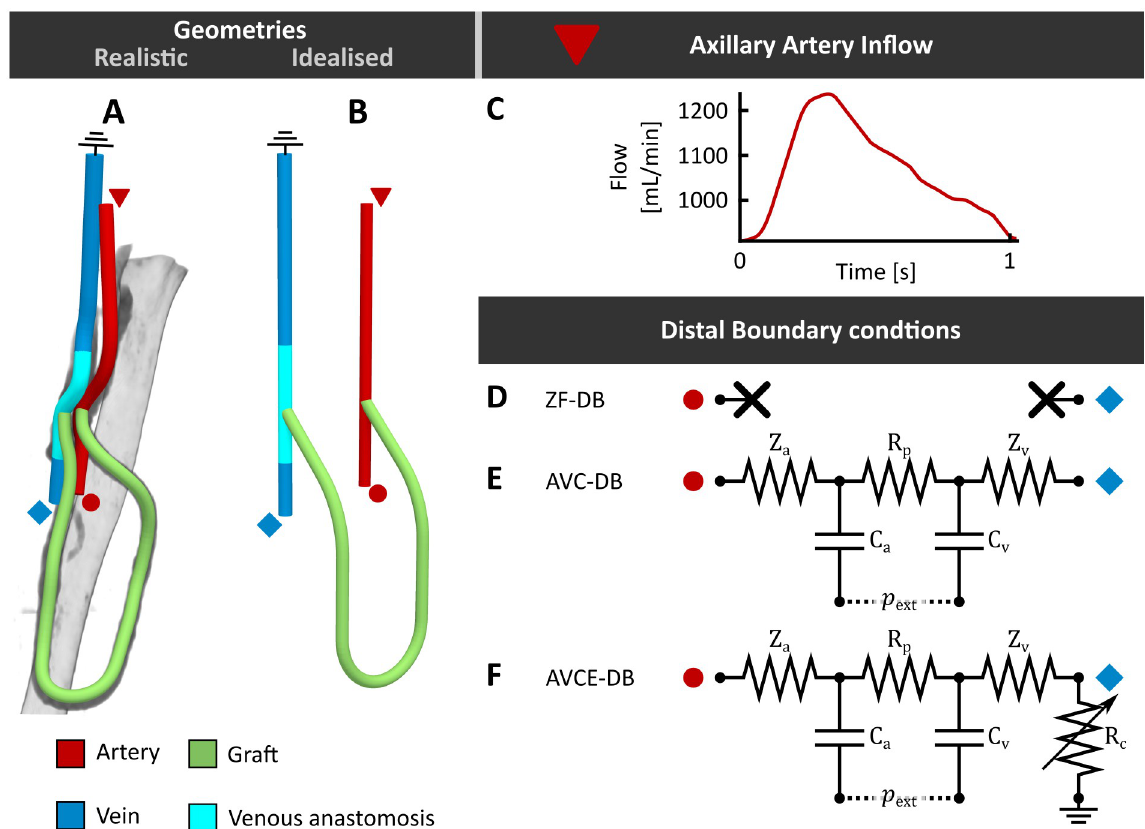
Fig 1. An overview of the realistic (A) and idealized (B) AVG model. Flow prescribed at the arterial inlet is presented in subfigure C. The distal boundary condition models that could be prescribed are presented in subfigures D—F. Note that the colored symbols in subfigures C—F correspond to the symbols near the boundaries in A & B and indicate where each boundary condition was